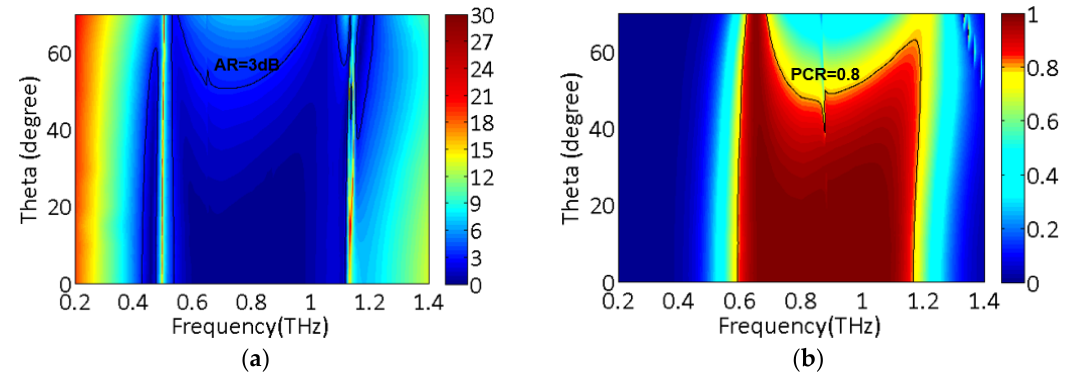
Figure 5. Frequency and Theta-dependent ( a ) AR and ( b ) PCR.